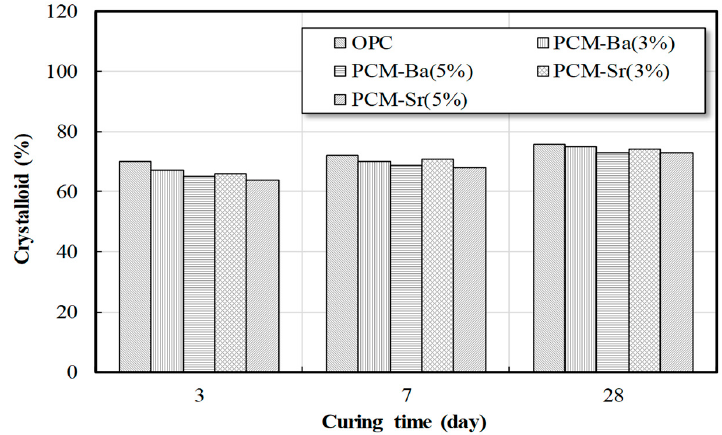
Figure 3. Crystalloid contents of cement mortar.